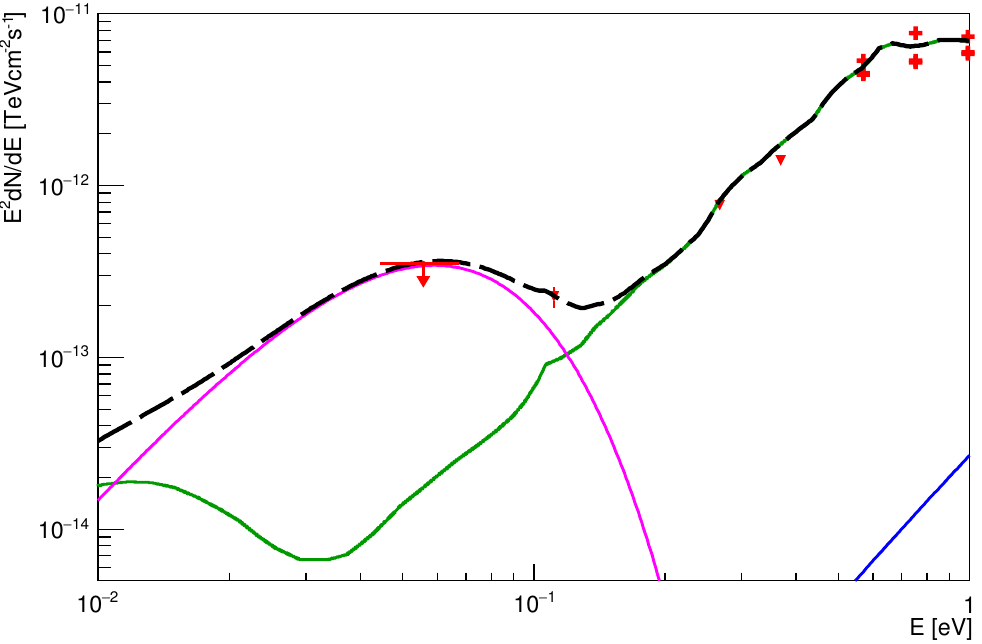
Figure 2. The infrared part of the SED for 1ES 0229+200. Colors are the same as in Figure